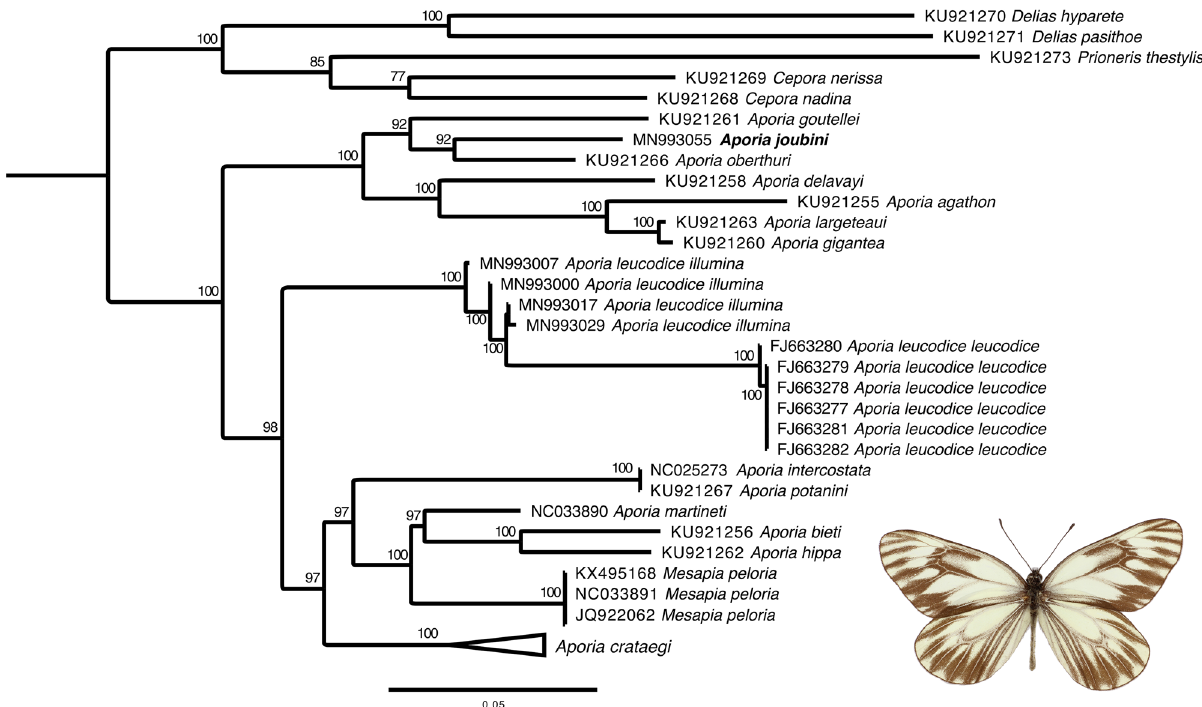
Figure 1. Maximum likelihood (ML) tree of the subtribe Aporiina under GTR CAT model of evolution; numbers above and below branches represent bootstrap support (BS) above 75%. Holotype of Aporia joubini NHMUK010201224 (image courtesy of NHM of London: Data Portal https ://data.nhm.ac.uk/datas et/56e71 1e6-c847-4f99-915a6 894bb 5c5de a/resou rce/05ff2 255-c38a-40c9-b657-4ccb5 5ab2f eb/recor d/66366